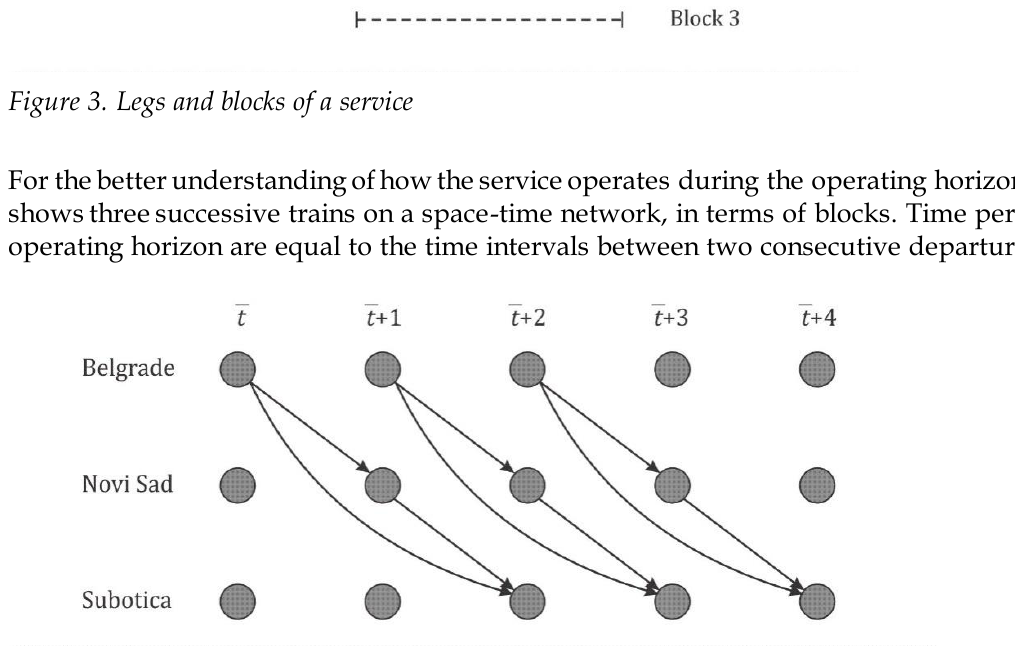
Figure 4. Service representation in terms of blocks during the operating horizon Time is discrete. We observe the finite operating horizon of 7 TUs, thus  1,...,7 t . The